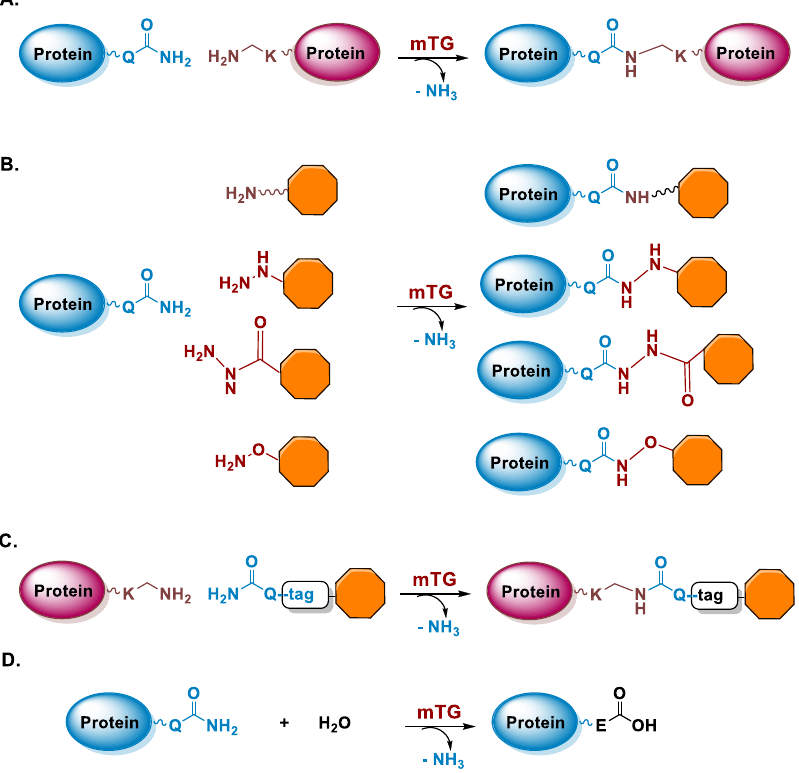
Figure 2. Reactions catalyzed by mTG. ( A ) If a Gln residue and the ε-amino group of a Lys residue of two proteins are involved, the reaction generates the formation of an isopeptide bond between the two residues leading to protein crosslinking. ( B ) If the primary ammine, hydrazine, hydrazide, or alkoxyamine belong to a ligand, the reaction leads to protein derivatization at the level of a Gln residue. ( C ) The ligand can also be functionalized with a Q-tag allowing protein conjugation at the level of Lys residues. ( D ) In the absence of primary ammines, in aqueous solution glutamine deamidation occurs, resulting in the conversion of glutamine into glutamic acid.